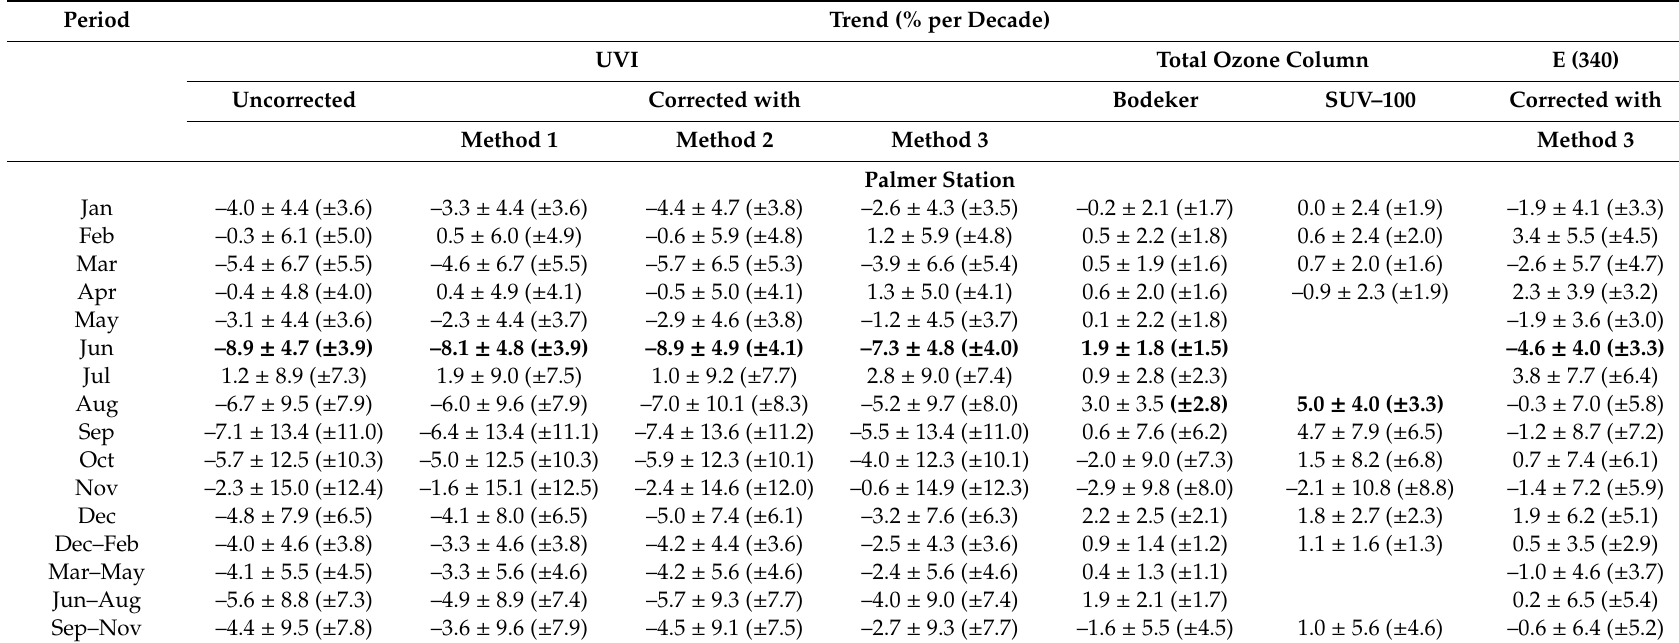
Table 3. Same as Table 2 but for Palmer